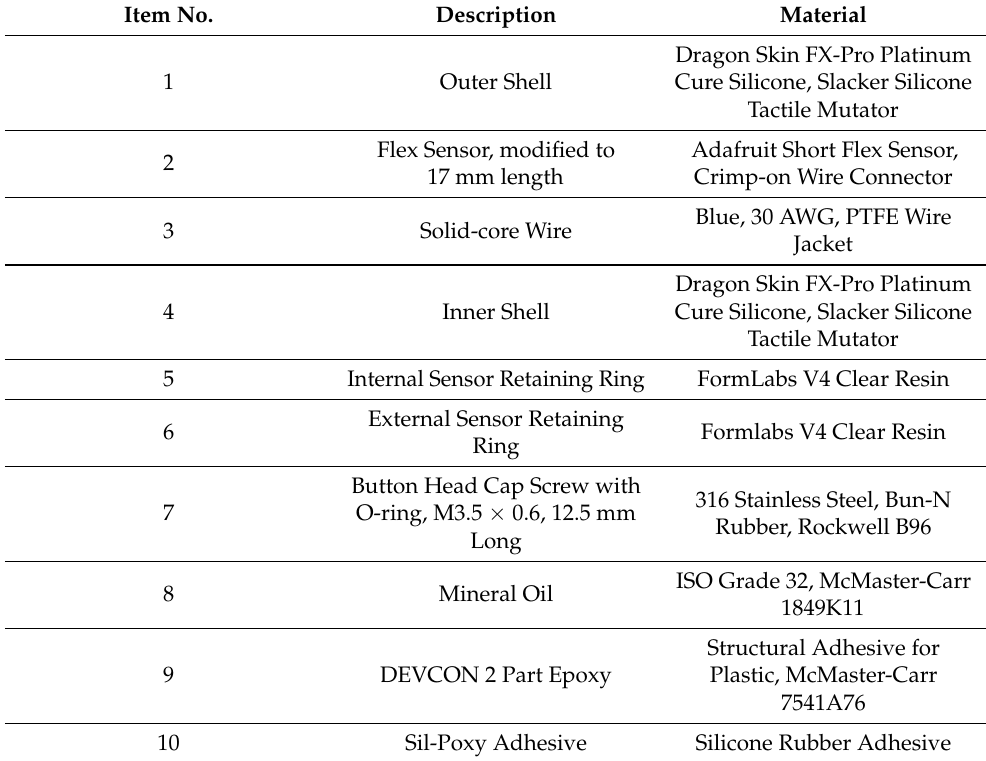
Figure 2. Projected and cross-sectional dimensions of the soft multi-directional force sensor; linear dimensions: mm, angular dimension: degrees. Table 1. Sensor components and